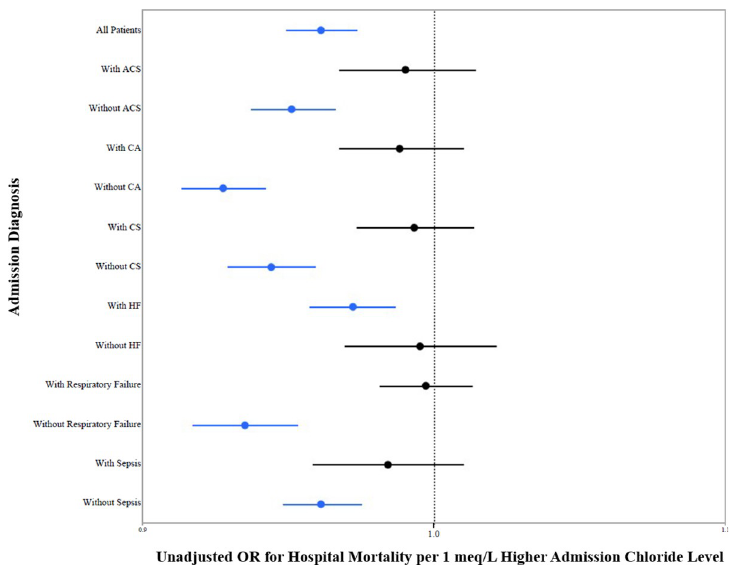
Fig 2. Hospital mortality and admission chloride level according to admission diagnosis.